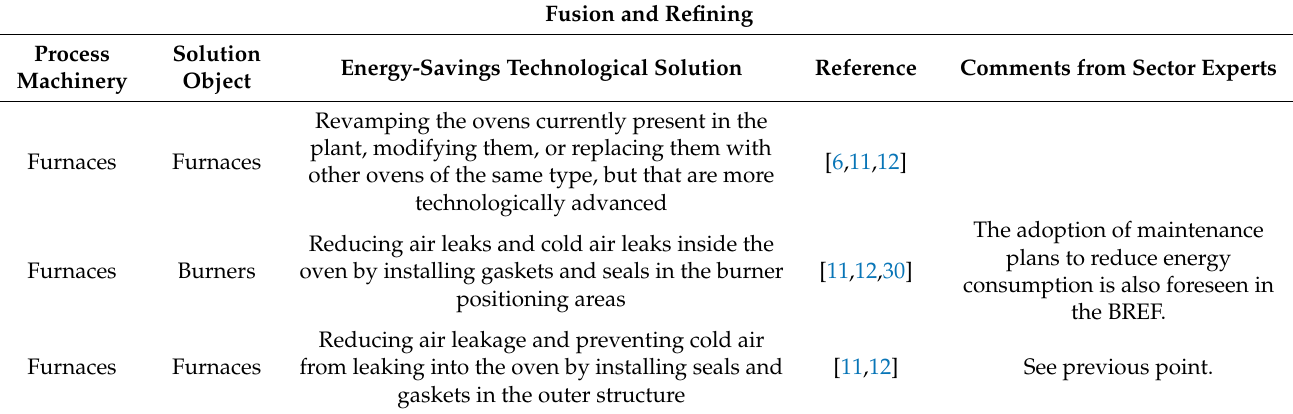
Table A2. Technology energy-savings for fusion and refining. Fusion and